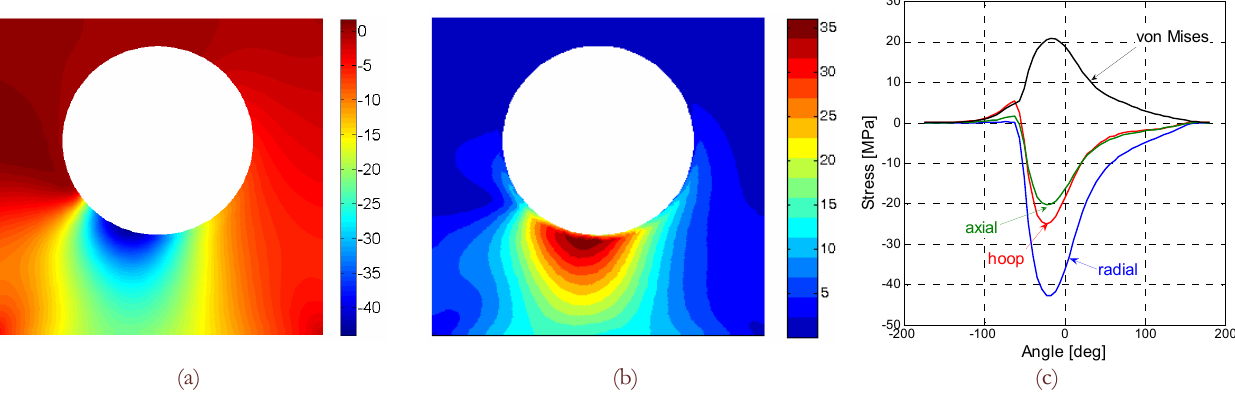
Figure 7: (a) Radial and (b) von Mises stresses in the support (MPa units); (c) stress components on inner surface of